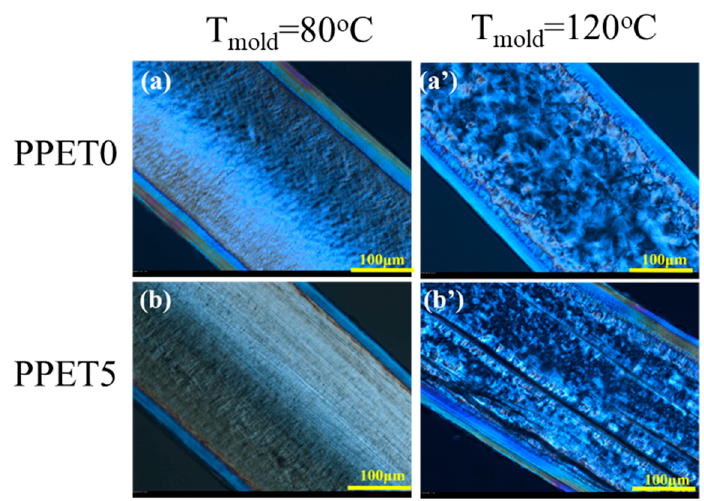
Figure 6. Polarized Light Microscope (PLM) images of crystalline structure in M-parts.